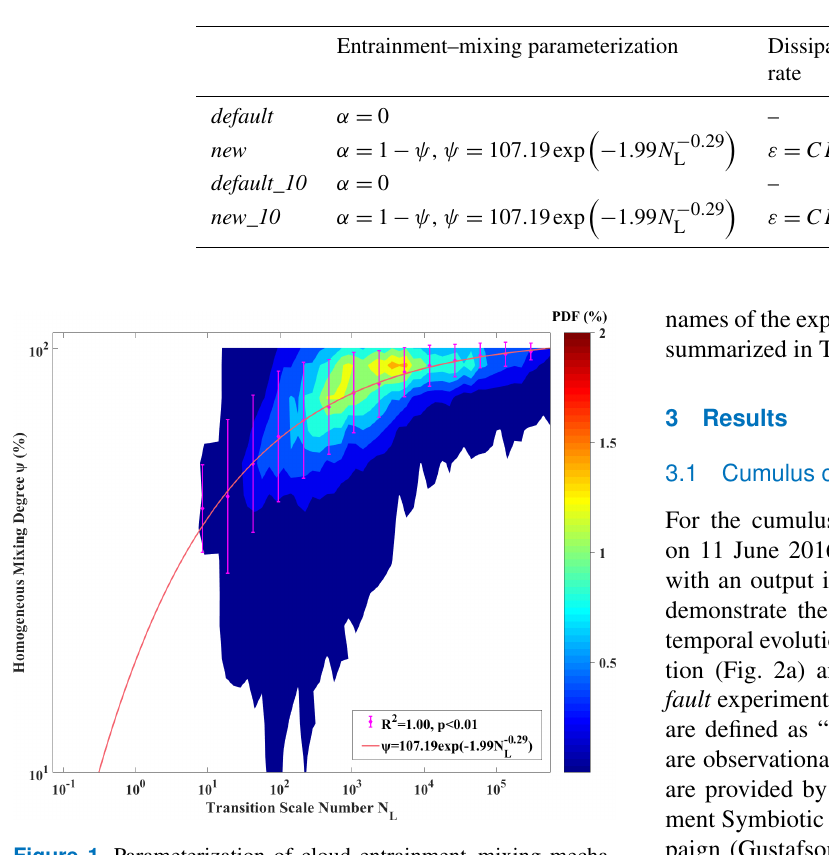
Table 1. Summary of names and corresponding descriptions of the four experiments for each case of cumulus and stratocumulus. The meaning of each symbol for each experiment can be found in the text.